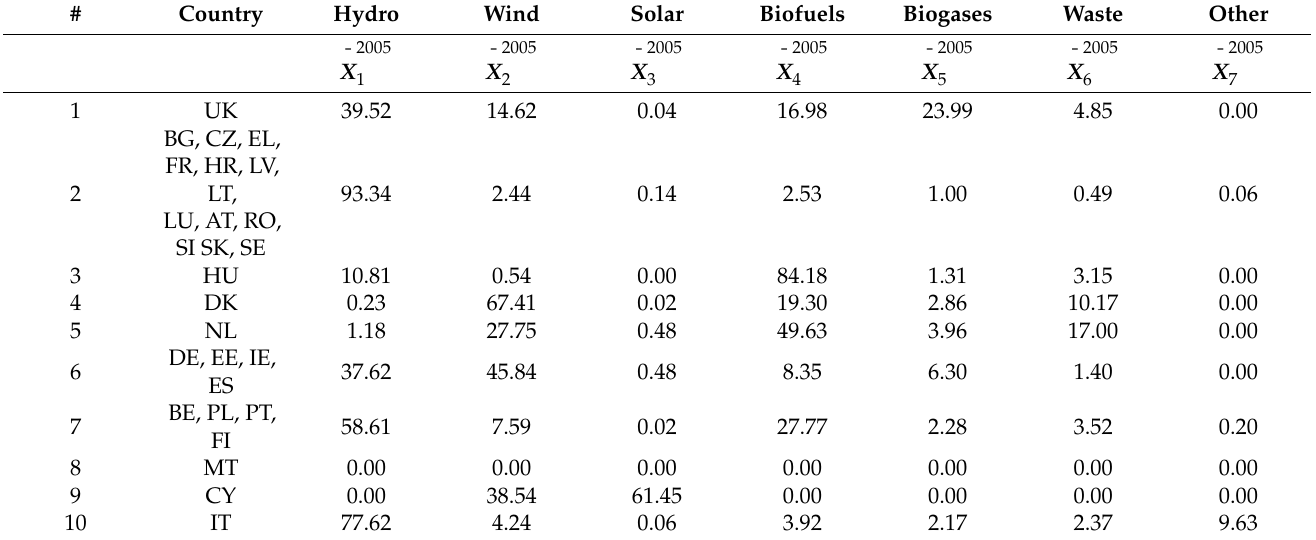
Table 5. The results of the classification of EU countries according to the shares of individual renewable energy sources in the production of electricity (clusters averages, %)—data from